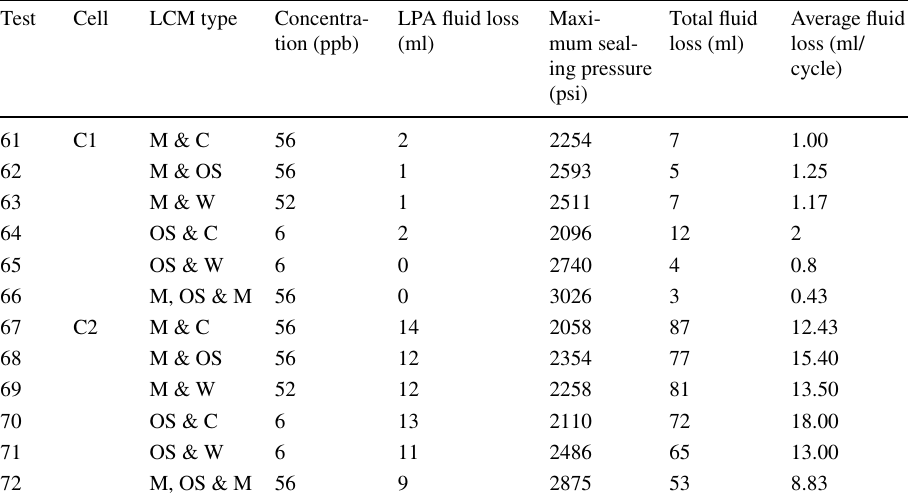
Table 13 Summary of